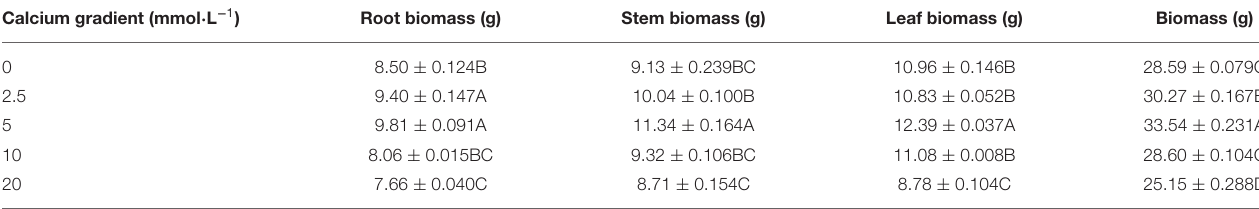
TABLE 1 | Biomass of poplar seedlings in different